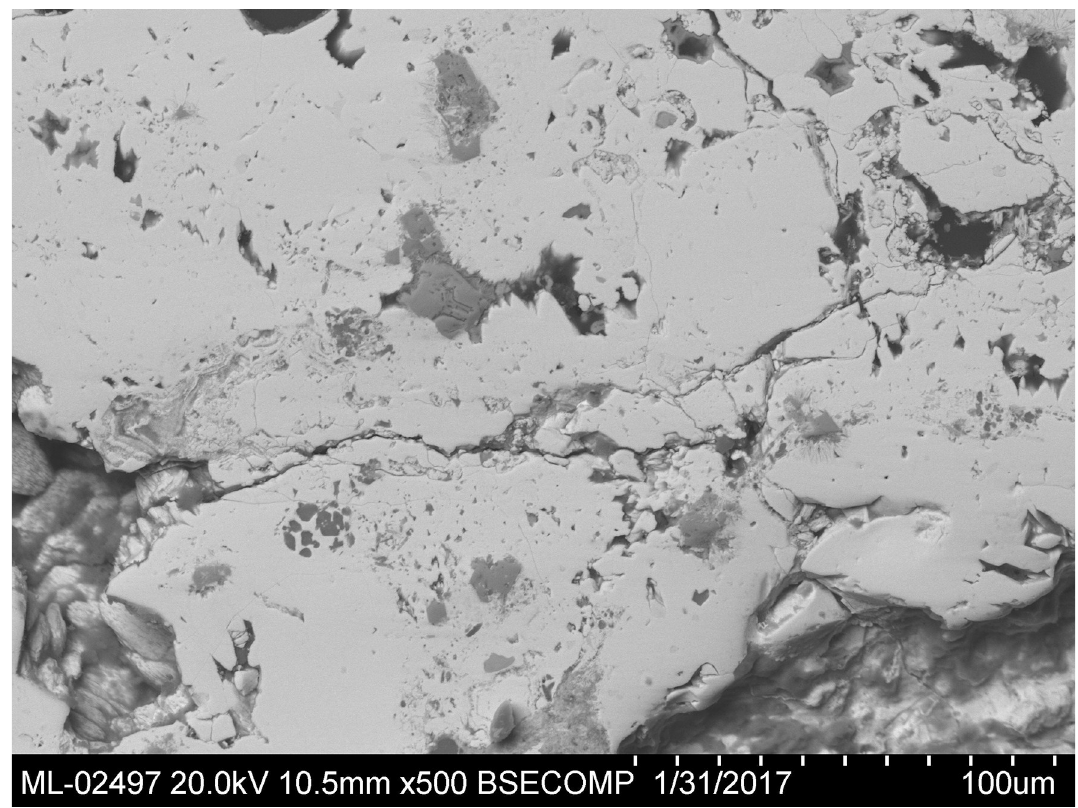
Fig 20. Detail of the lead oxide layer (white) showing the grey inclusions of complex oxides containing Fe, Zn, Pb and Cu. Bleje ş ti 1–1 sample. SEM image, backscattered electrons (S. Rovira).